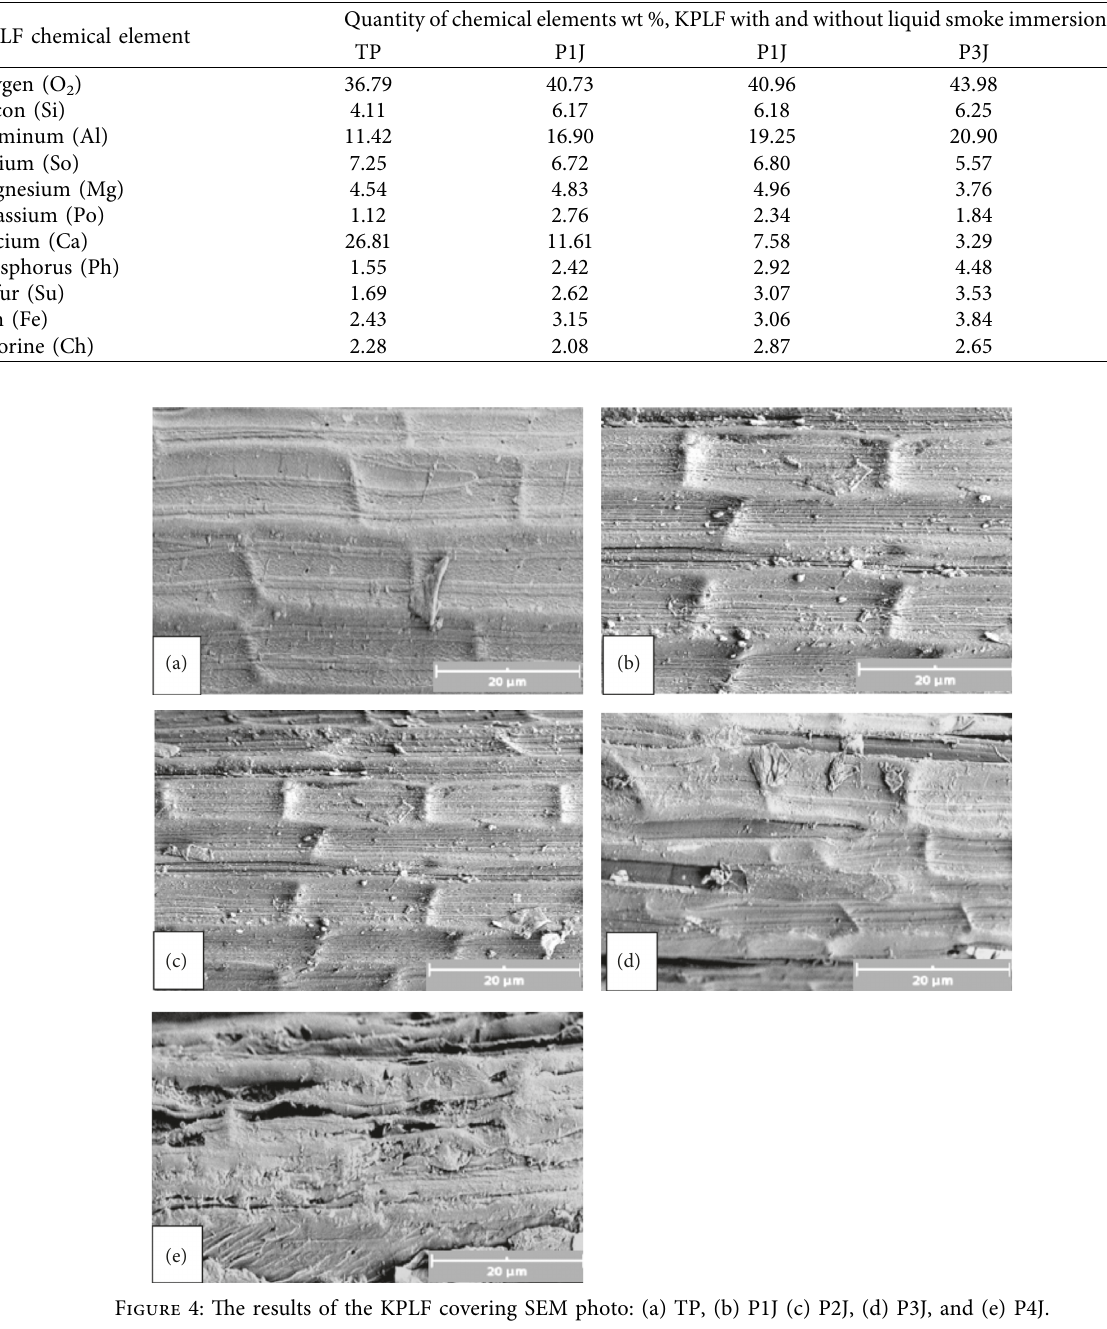
Table 2: SEM test results (EDS) of chemical elements contained in KPLF.